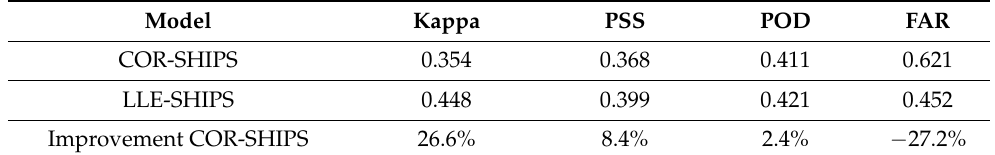
Table 9. Performance comparison between the model developed in this study and the baseline COR-SHIPS model. The values for COR-SHIPS model are copied from Table 9 of